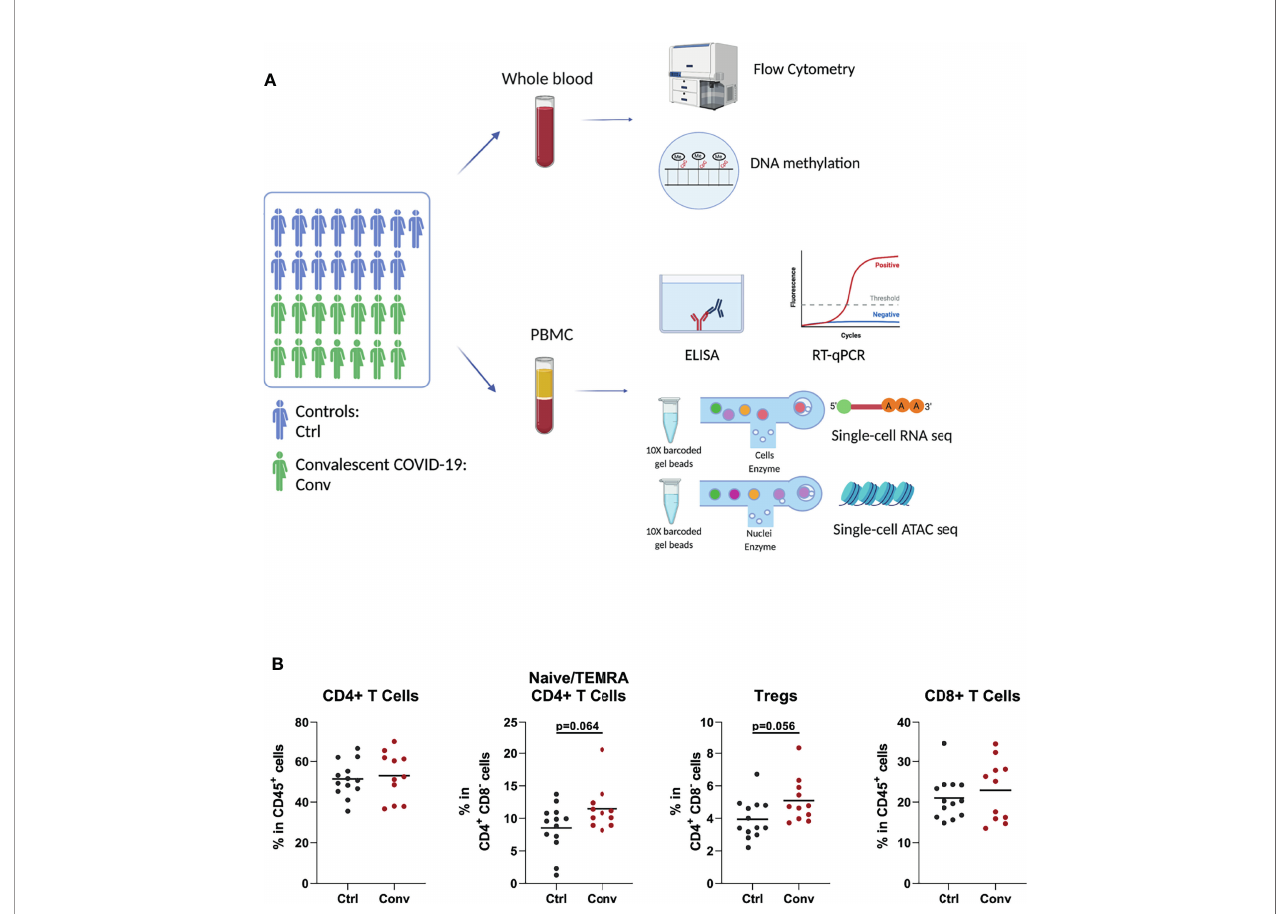
FIGURE 1 | Study design and immune cell populations of healthy controls and convalescent COVID-19 patients. (A) The summary of the experiments performed in the study. Blood was drawn from 15 healthy controls and 14 convalescent COVID-19 patients. Flow cytometry, RT-qPCR, and ELISA were performed to determine the cell counts, assess interferon stimulated gene expressions, and measure the cytokine levels in culture supernatants, respectively. Single-cell RNA sequencing was used to determine the transcriptome. Single-cell ATAC sequencing and whole-genome methylation assay were performed to analyze the epigenetic differences between convalescent COVID-19 individuals and controls (This fi gure was created with BioRender.com). (B) Dot plots showing proportions of T cell subsets between the convalescent COVID-19 individuals and controls from fl ow cytometry. Mann-Whitney test was used to analyze the differences between controls (black dots) and convalescent patients (red